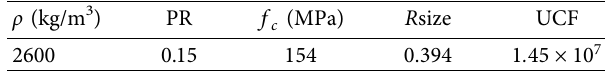
Figure 4: Finite element model of 3D-Voronoi diagram and stone concrete. (a) Finite element model of 3D-Voronoi diagram. (b) Finite element model of stone concrete. Table 2: Material parameters of